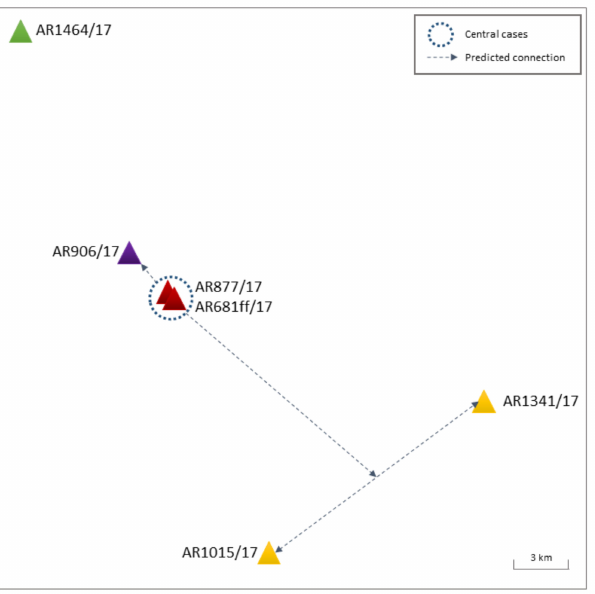
Figure 2. Graphic representation of Cluster I BB H5N8 in poultry holdings. Holdings are colored in red, purple, yellow, and green, as described in the main text. For reasons of anonymity, no explicit locations are shown. Dotted circles—central cases, dotted lines—predicted